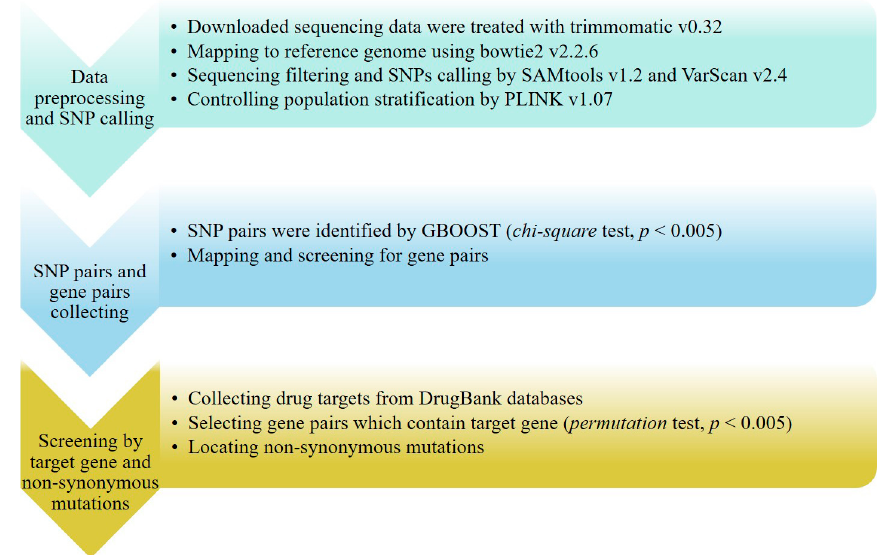
Figure 3. The workflow of the method used in this study.